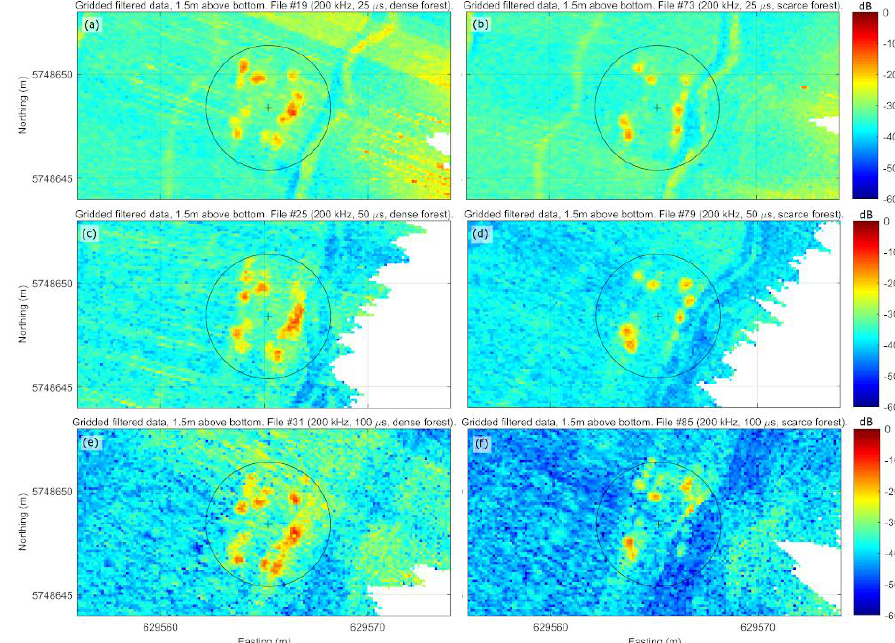
Figure 8. Horizontal slice-through at 1.5 m above the seafloor for a file acquired at 200 kHz over the dense or thin forest patch, using different pulse length settings: ( a ) 25 μs pulse data on dense forest, ( b ) 25 μs pulse data on thin forest, ( c ) 50 μs pulse data on dense forest, ( d ) 50 μs pulse data on thin forest, ( e ) 100 μs pulse data on dense forest, ( f ) 100 μs pulse data on thin forest . The cross is the centre of the patch. The 3 m radius circle is the base of the target volume.